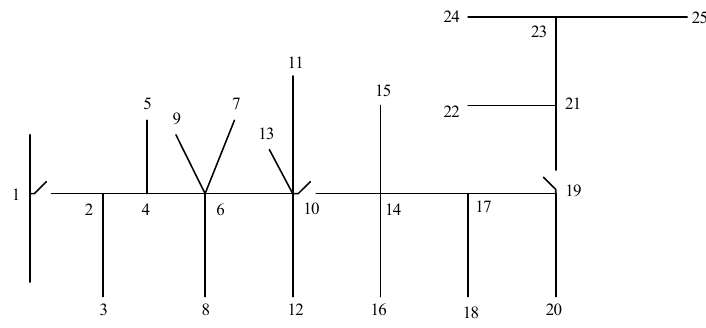
Figure 8. Example 1: optimal switch-distribution map (no contact, two switches).